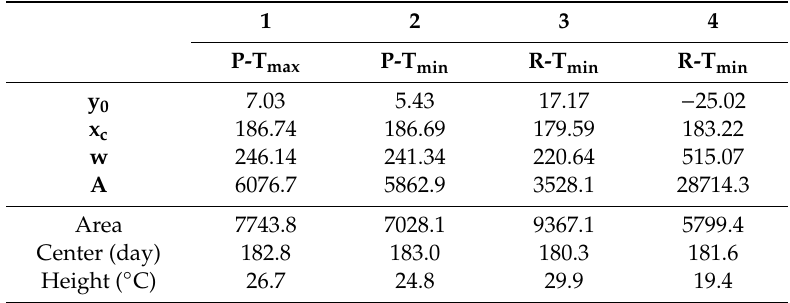
Table 2. Parameters of Gaussian fittings for each temperature graph in Figure 1a. Prototype maximum temperature (P-T max (1)) and minimum temperature (P-T min (2)). Reference maximum temperature (R-T max (3)) and minimum temperature (R-T min